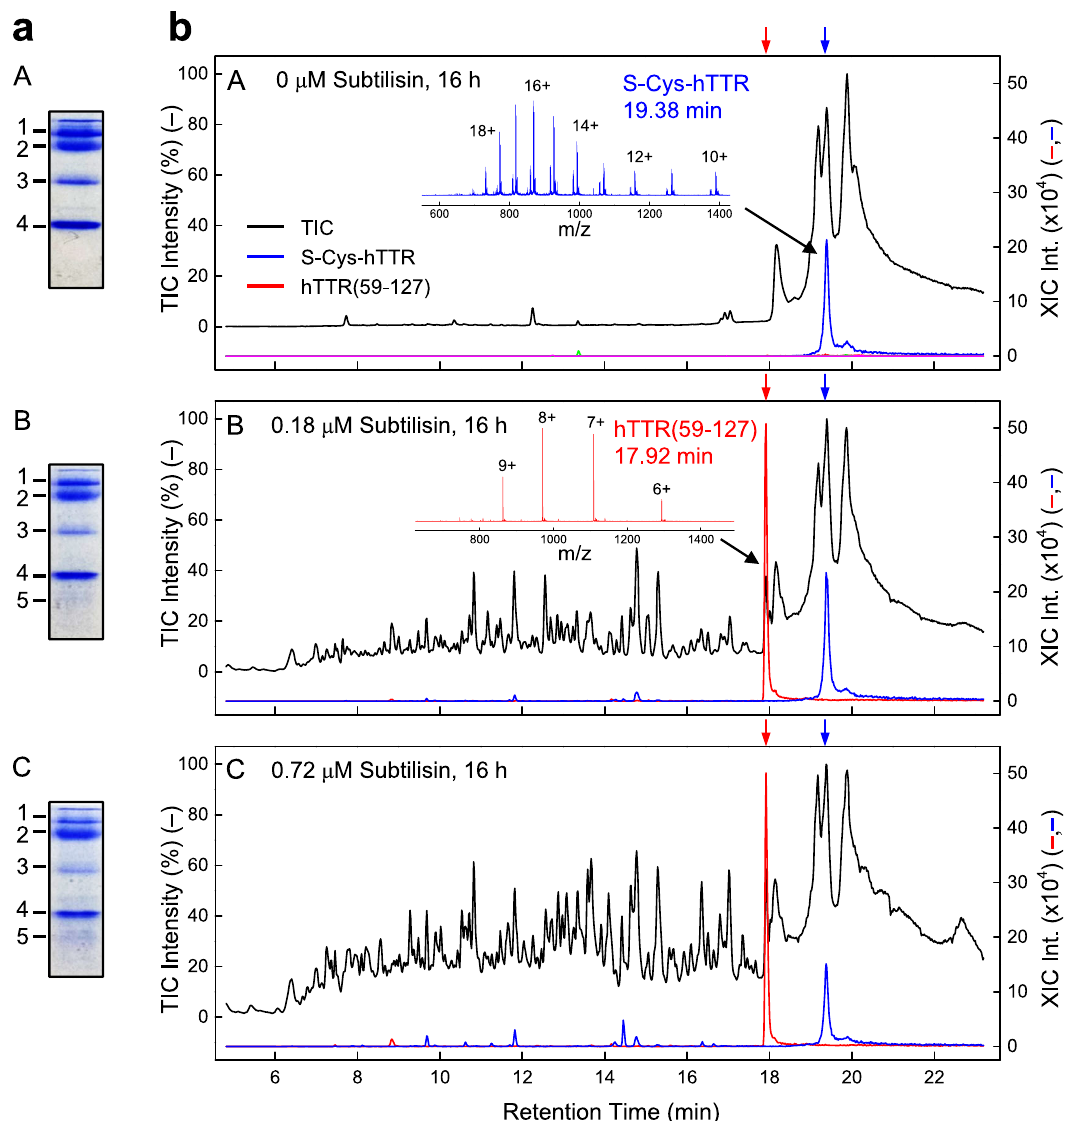
Fig. 8 Generation of hTTR(59 – 127) in human plasma. Aliquots (800 μ l) of human plasma were treated with subtilisin at different concentrations (0, 0.18, and 0.72 μ M) at 37 °C under constant agitation (500 rpm). After 16-h reaction, plasma samples were processed following the phenol precipitation protocol (see “ Methods ” section) and analysed by SDS-PAGE and UPLC-MS. a SDS-PAGE (4 – 14% acrylamide) analysis under reducing conditions of phenol-treated plasma samples (8 μ g). Proteins were identi fi ed by in situ tryptic digestion and peptide mass fi ngerprint analysis (see “ Methods ” section): 1, IgG heavy chain; 2, α 1 -acid-glycoprotein 1; 3, IgG light chain; 4, hTTR; 5, hTTR(59 – 127). b Representative UPLC-MS chromatographic pro fi les of phenol- treated plasma samples before ( A ) and after (B, C) 16-h incubation with increasing subtilisin concentrations. In each panel, the black trace reports the total ion current (TIC) pro fi le, expressed in percentage, while the blue and red traces track the intensities of the highest m / z values of S-Cys-hTTR ( m/z = 817.472) and hTTR(59 – 127) ( m/z = 970.492) in the eXtracted Ions Chromatograms (XIC). The arrows refer to the retention times in the XICs of phenol- treated plasma samples spiked with hTTR (blue arrow) or hTTR(59 – 127) (red